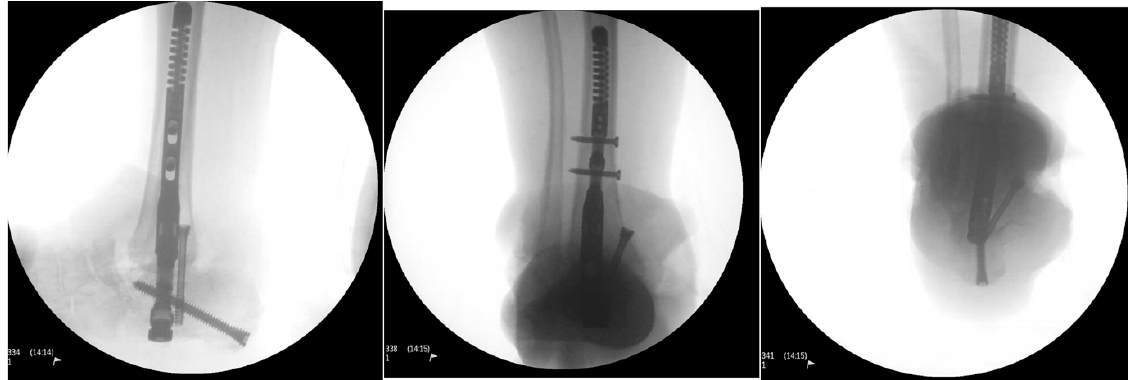
Figure 7. Intraoperative fluoroscopic images showing restoration of axial alignment with retrograde hindfoot nail and headless compression screw.